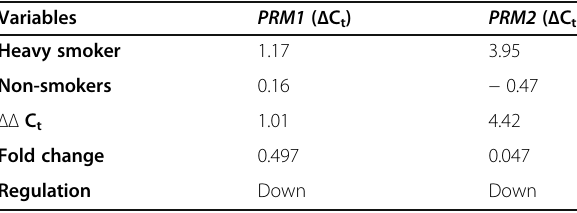
Table 3 Transcription levels of PRM1 and PRM2 genes in spermatozoa of heavy smokers compared to non-smokers ( n = 188)